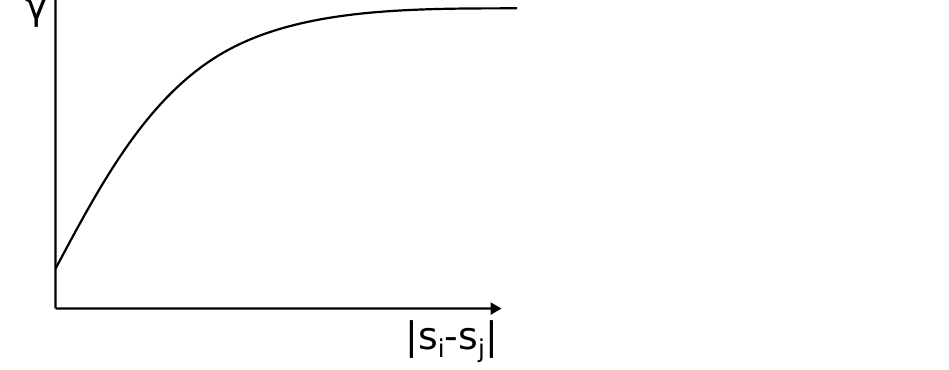
Figure 5. A theoretical variogram. The further two points are, their correlation becomes less and less significant up until a final cutoff